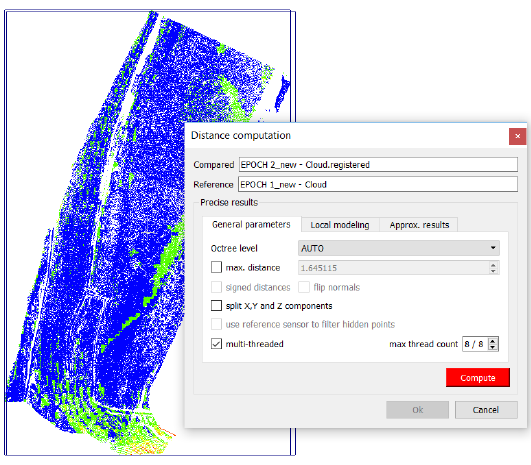
Figure 18. C2C distance computation menu provide by the CloudCompare software